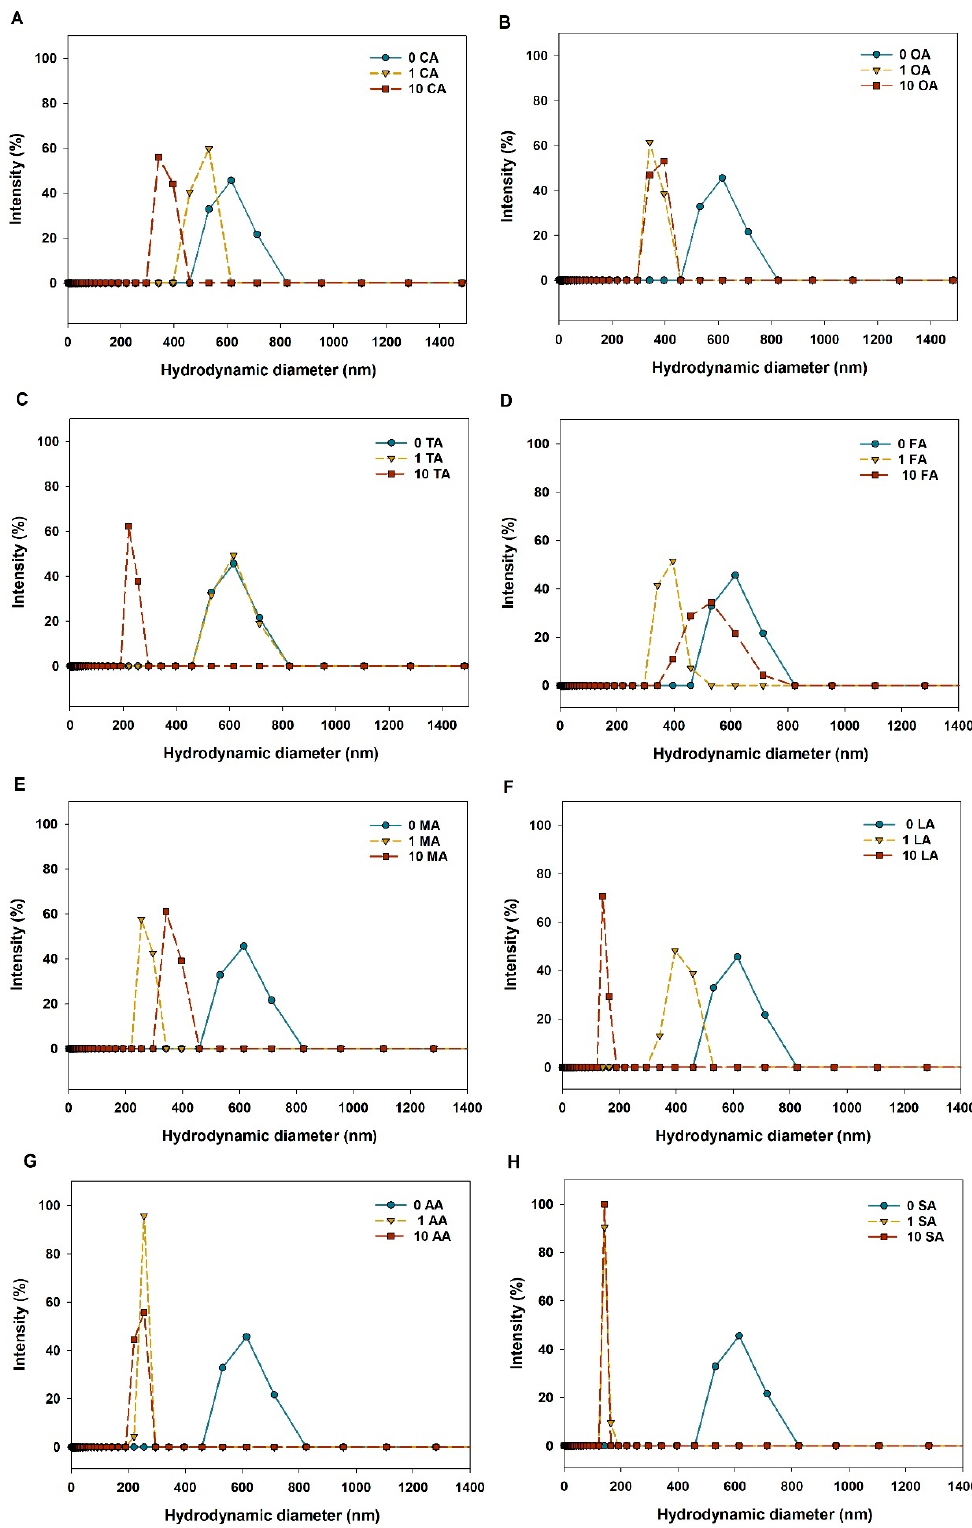
Figure 2. Size distribution of CuO nanoparticles (NPs) (100 mg/L) in aqueous solutions with different low-molecular-weight organic acids (LMWOAs). ( A ) CA: Citric acid; ( B ) OA: Oxalic acid; ( C ) TA: Tartaric acid; ( D ) FA: Formic acid; ( E ) MA: Malic acid; ( F ) LA: Lactic acid; ( G ) AA: Acetic acid; ( H ) SA: Succinic acid.